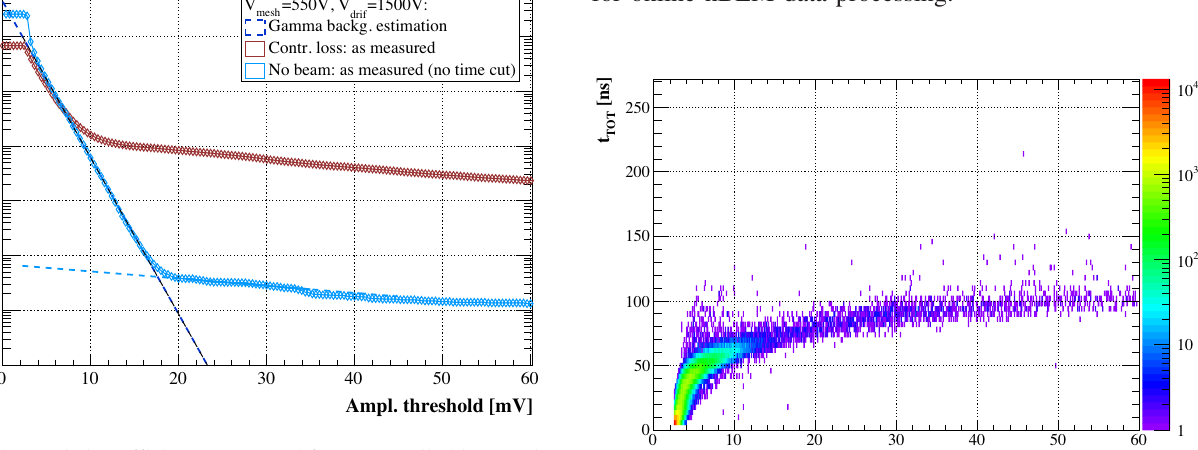
for the data TOT